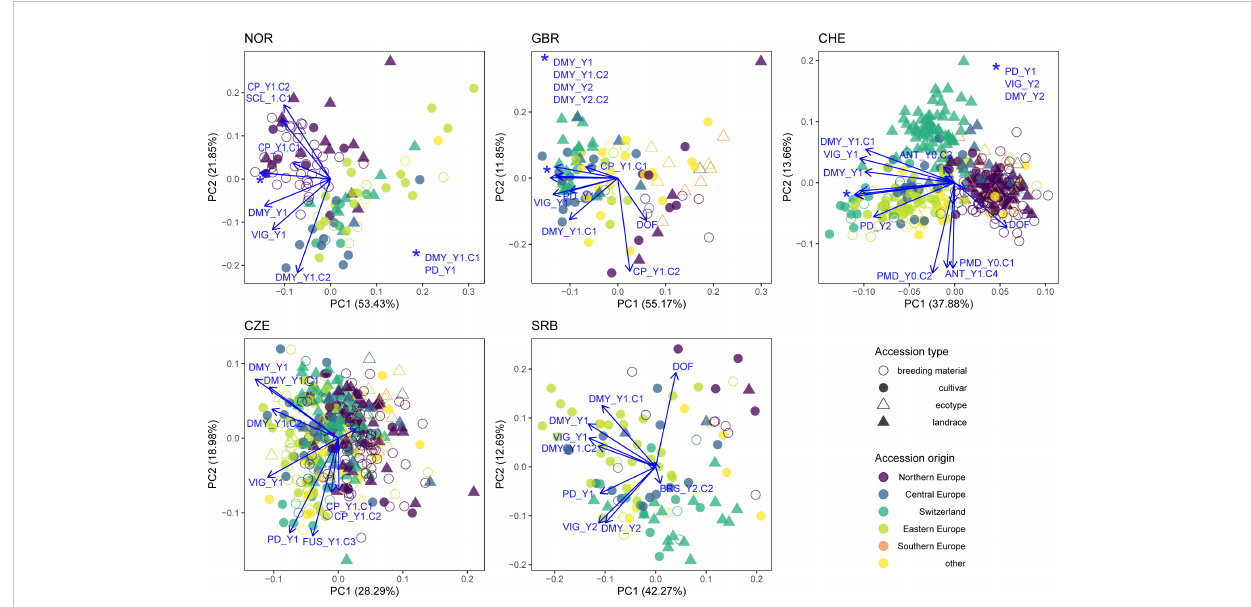
FIGURE 8 Principal component analysis (PCA) for each trial location including phenotypic data (DMY_Y1.C1, DMY_Y1.C2, CP_Y1.C1, CP_Y1.C2, DMY_Y1, DMY_Y2, VIG_Y1, VIG_Y2 and PD_Y1), disease scoring (ANT = southern anthracnose, BRS = brown spot, FUS = fusarium plant rot, PDM = powdery mildew, SCL = clover rot) and where they occurred. Colors indicate the region of origin of the accessions and symbols indicate the accession